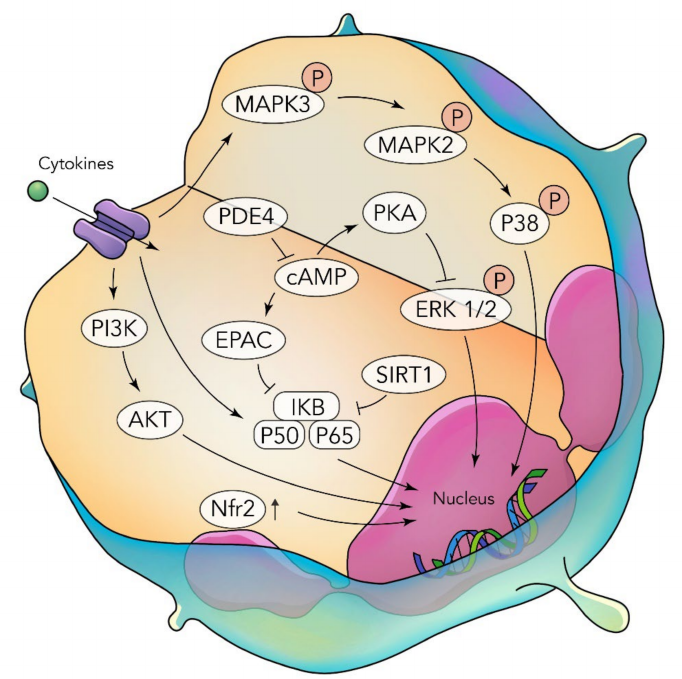
Figure 2. Cytokine-mediated mechanistic pro-inflammatory pathways in a neutrophil